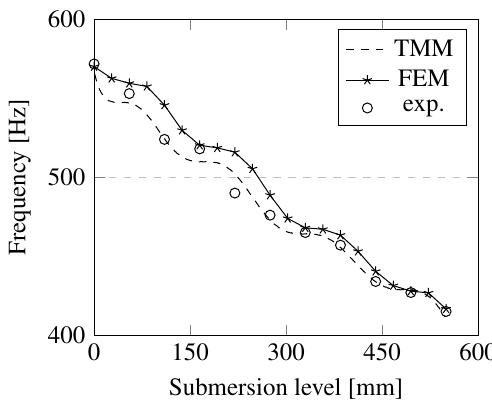
Fig. 8. Third natural frequency during